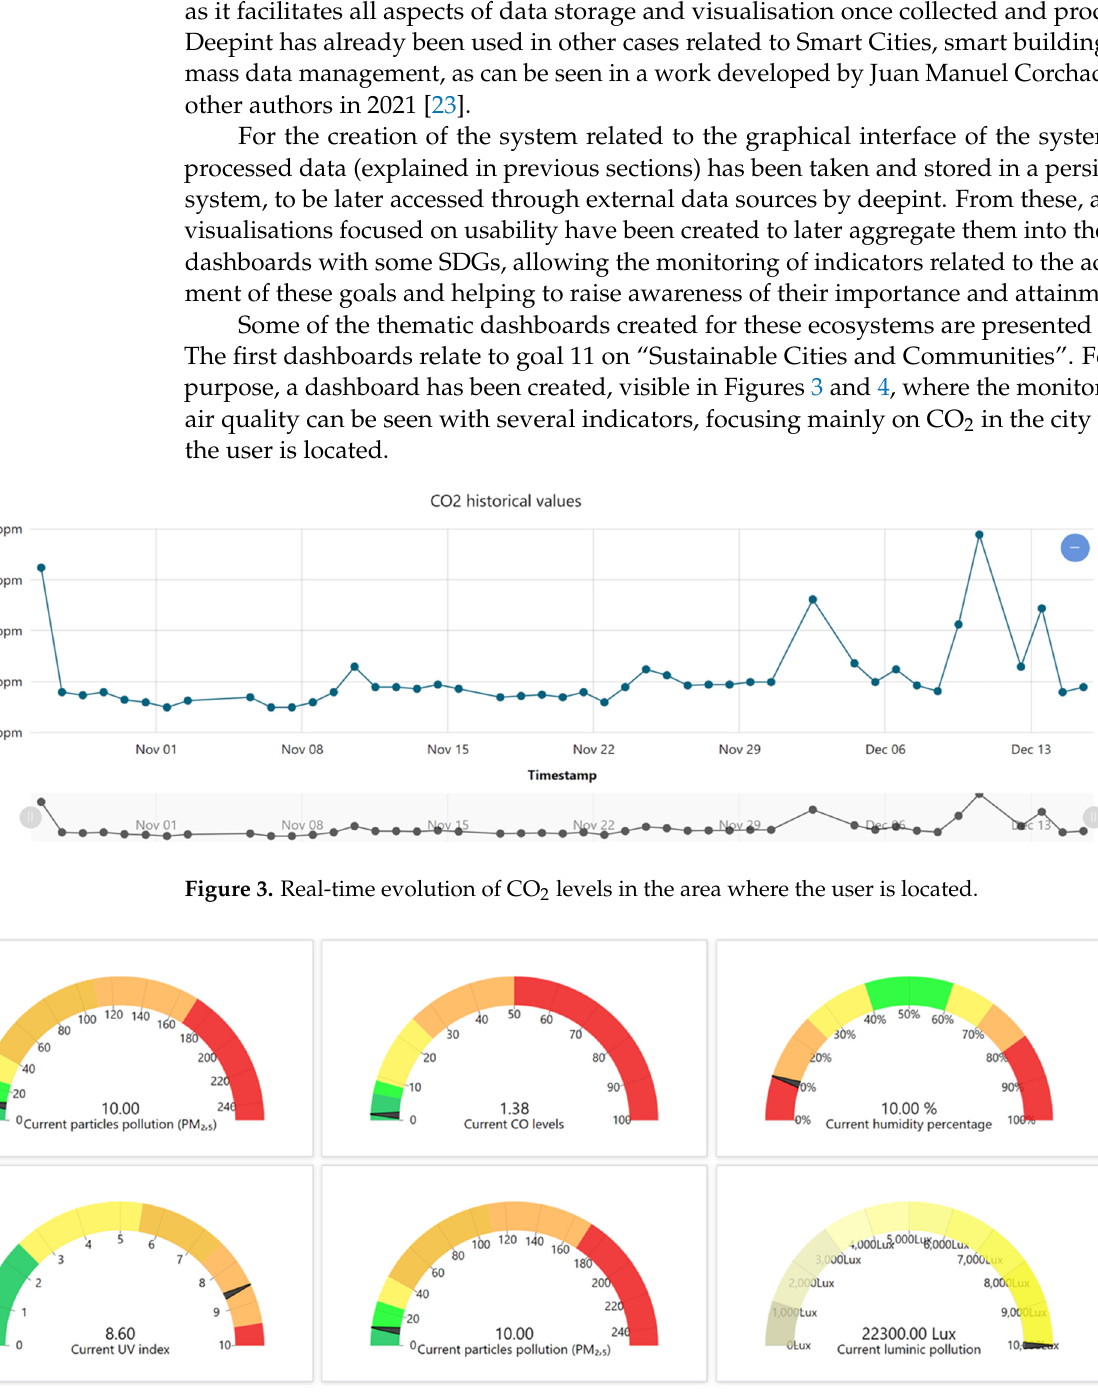
Figure 4 . Current values of various air quality indicators in the area where the user is located .